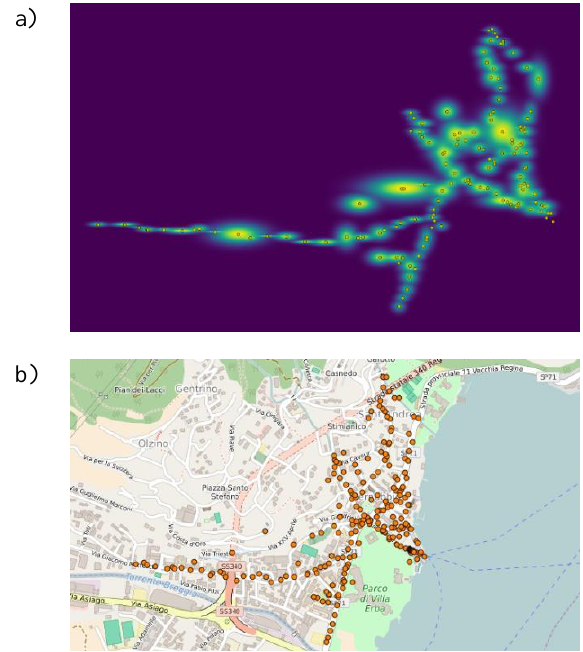
Figure 14. a) MEP-Clustering algorithm result and b) cluster visualization in